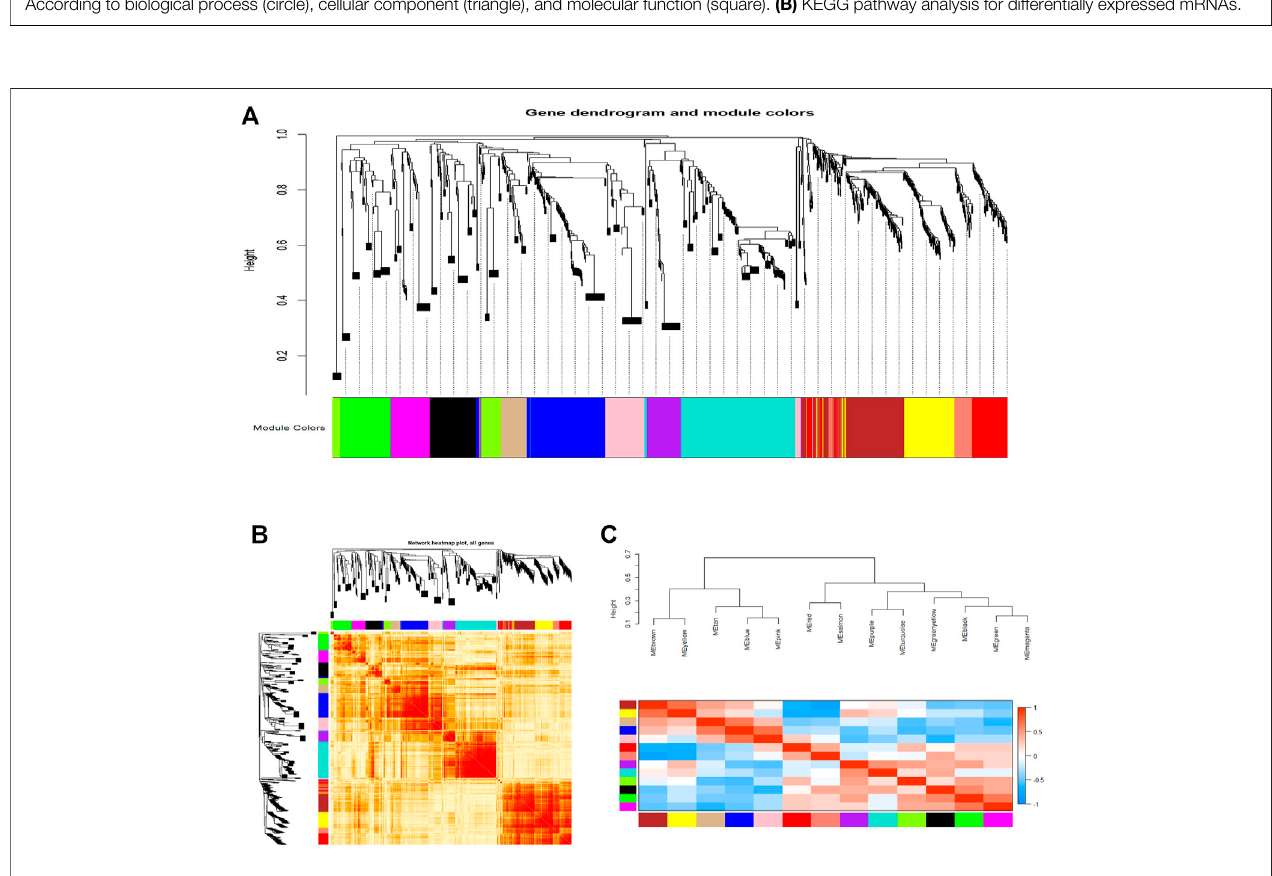
FIGURE 3 | WGCNA revealed gene co-expression modules in the CD4+ T cells of relapsed GD patients. (A) Clustering dendrograms of mRNAs and lncRNAs. Each color represents a co-expression module. (B) Network heatmap plot in the co-expression modules. (C) Eigengene dendrogram and eigengene adjacency